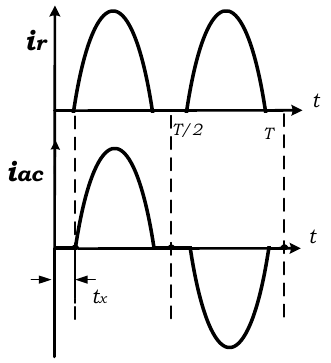
Figure 5. Current waveforms of the topology i ac and i r .